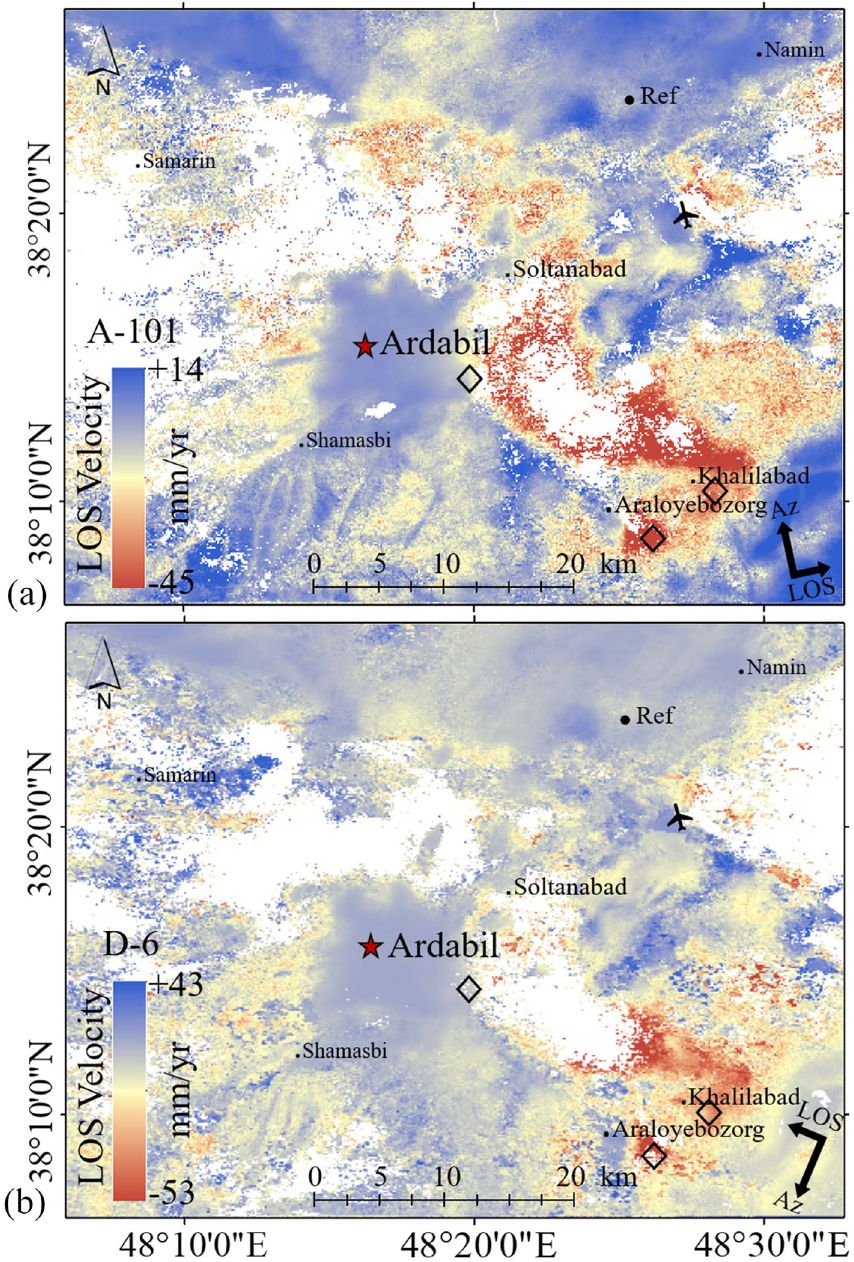
Figure 6. Mean LOS velocity of the results S1A images by LiCSBAS and displacement relative to the reference point. ( a ) From October 2014 to January 2021 for D-6 track, and ( b ) From November 2014 to September 2020 for A-101 track. This figure was created using the QGIS version 3.14.0-Pi software (https:// qgis. org/ en/